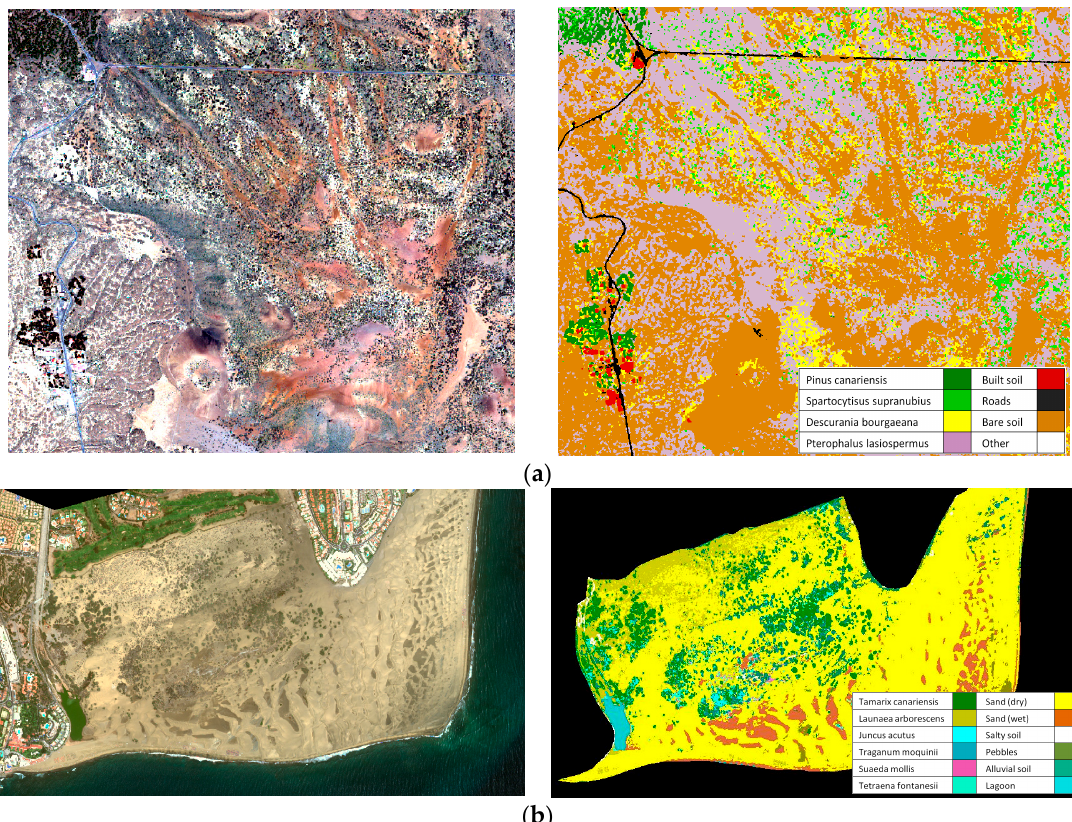
Figure 10. Vegetation maps using the SVM algorithm: ( a ) Teide National Park (16 May 2011); ( b ) Maspalomas Special Natural Reserve (4 June 2015).